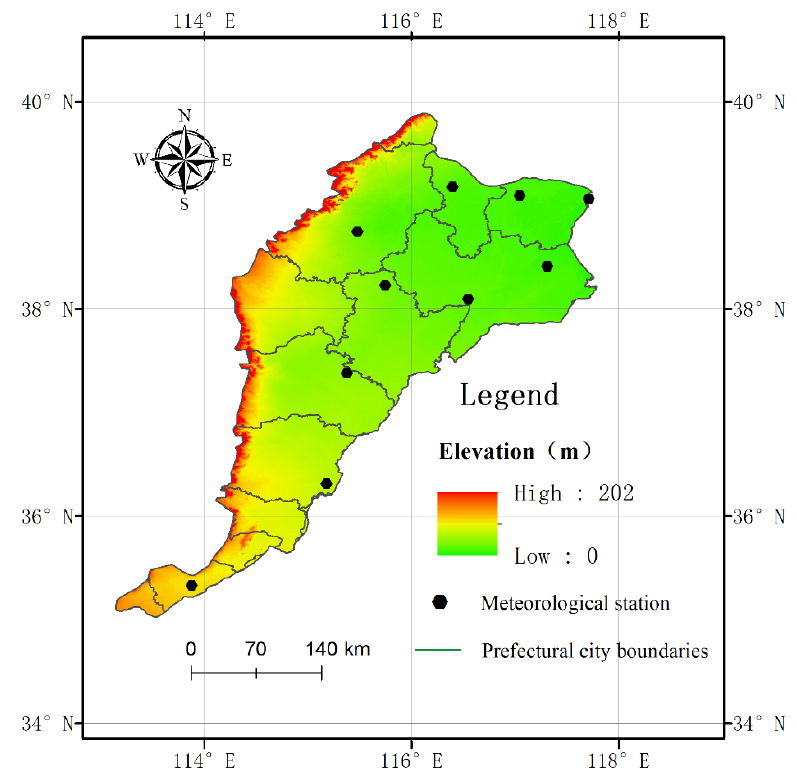
Figure 1. Locations of the study area, meteorological stations, and elevation information.